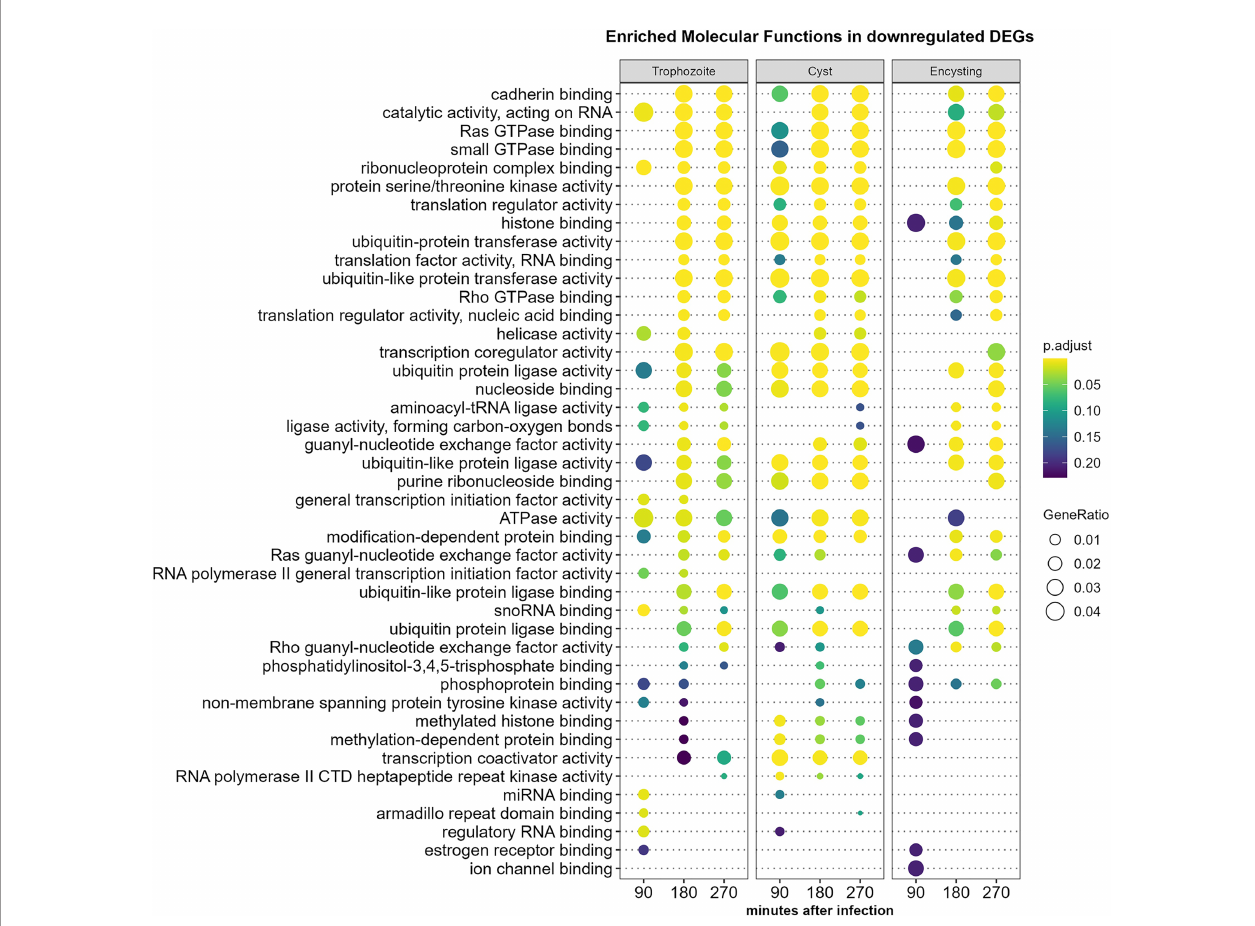
FIGURE 3 | Molecular function enrichment analysis of down-regulated Caco-2 genes (more than twofold) during Giardia infections. Comparison of the top 10 gene ontology (GO) terms in molecular function in each of the different Giardia stage infections (trophozoite, cyst and encysting cells Caco-2 infections) and infection time points (1.5h, 3h, and 4.5h post-infection). Circle size and color indicate the gene ratio (number of differentially expressed genes against the number of genes associated with a GO term) and their signi fi cance, respectively. GO, gene ontology; MF, molecular